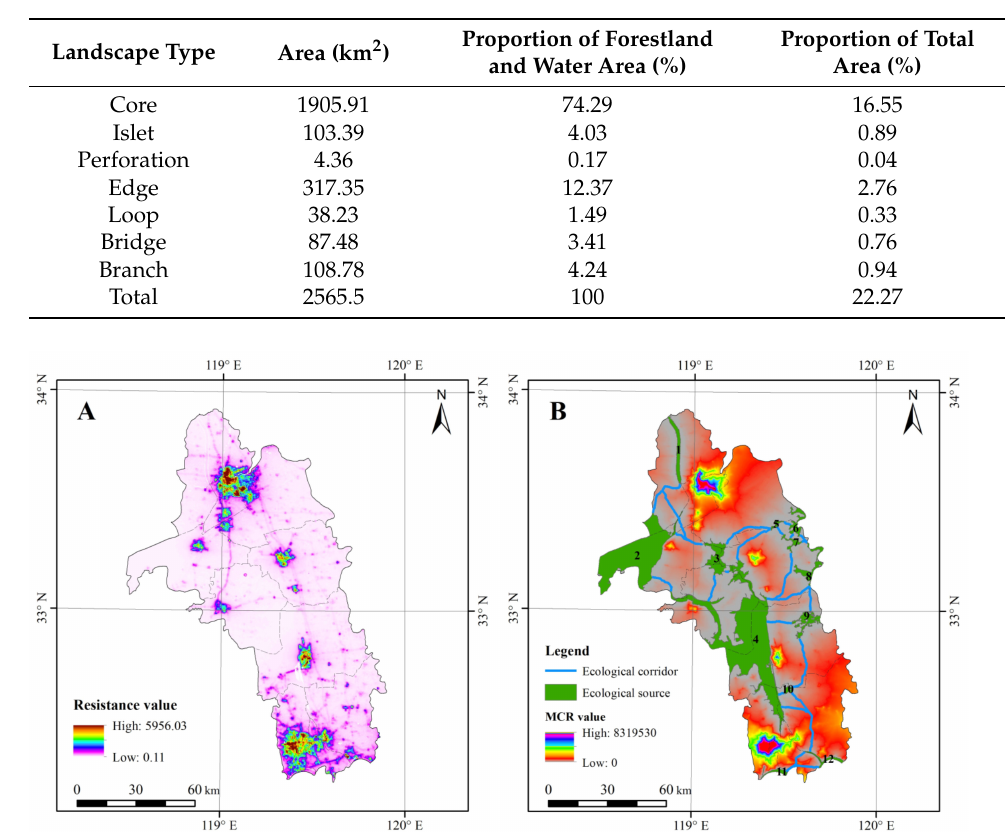
Figure 7. Landscape pattern based on MSPA ( A ) and spatial distribution of ecological sources ( B ). Table 4. Area of each landscape type based on MSPA.